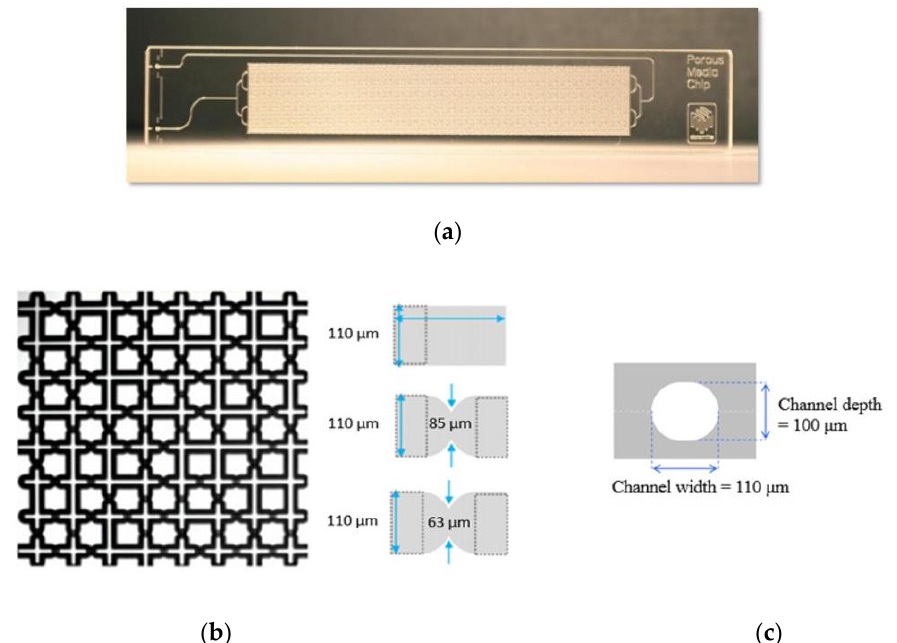
Figure 1. Microfluidic model pore network used in the experiments: ( a ) image of the device, the porous area is 10 × 60 mm 2 ; ( b ) detail of the square network with constricted capillaries with different geometry; ( c ) cross section of the channels.